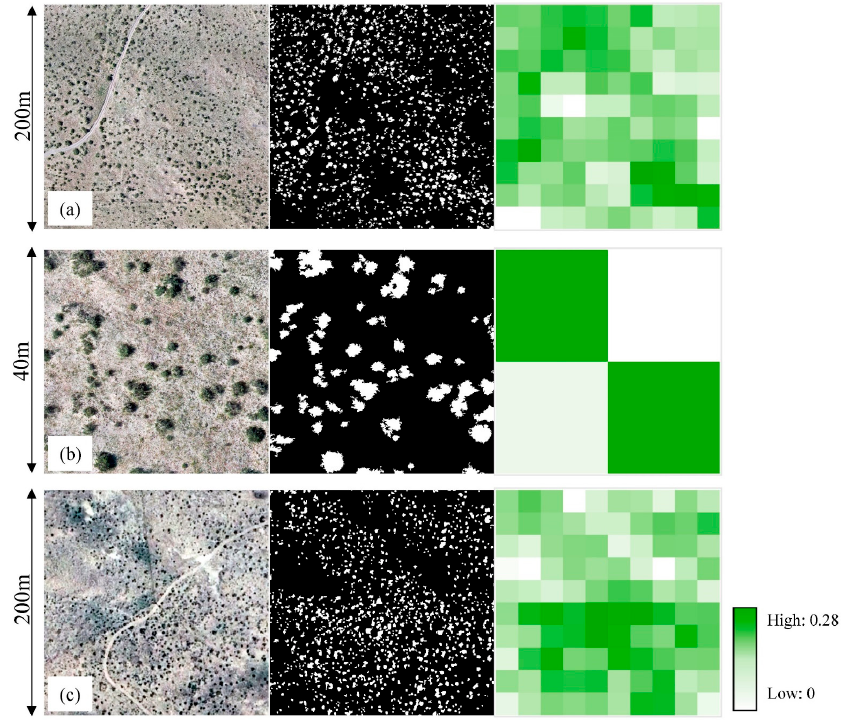
Figure 2. Examples of the original AE and GE image (left), the object-oriented classification results (middle) and the shrub coverage with a resolution of 20 m (right). ( a , b ) are AE samples, and ( c ) is GE sample.